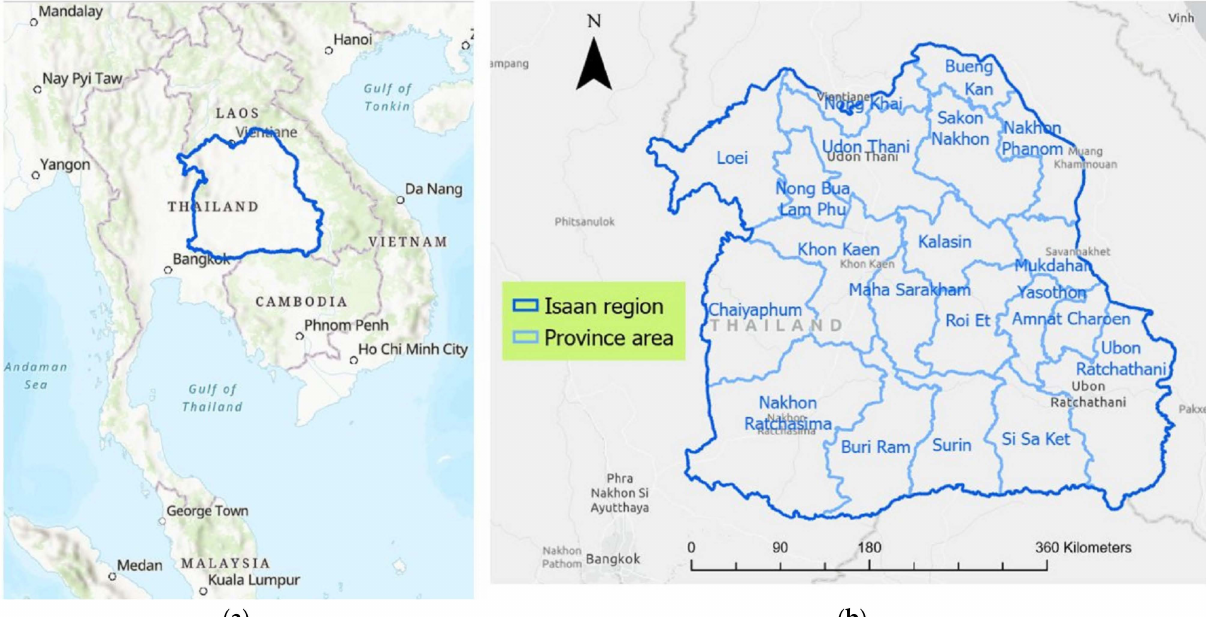
Figure 1. Study area, Isaan region of Thailand: ( a ) location in Northeast Thailand; ( b ) the 20 provinces which make up the